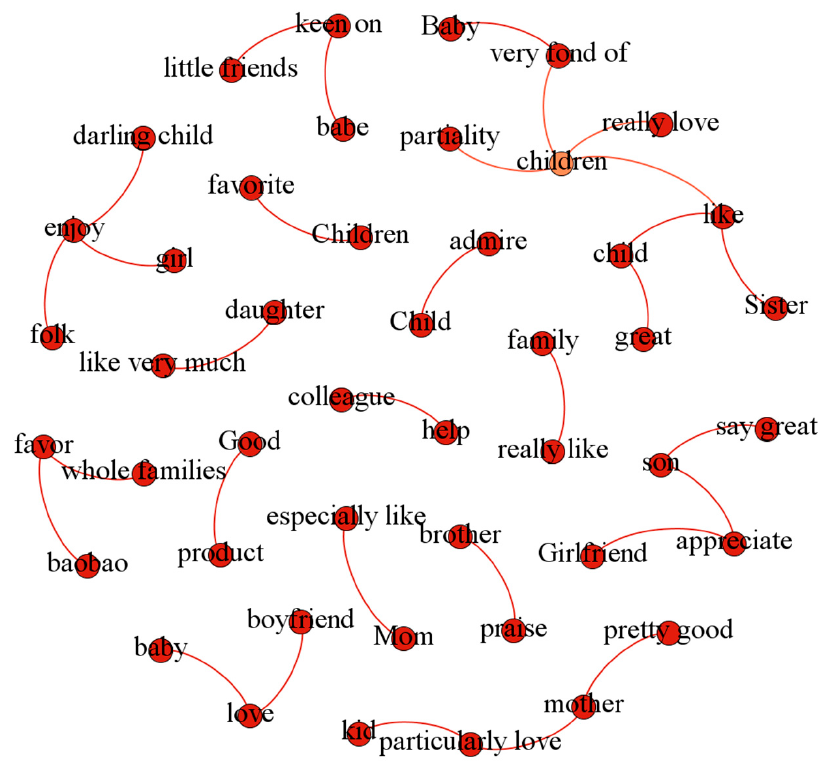
Figure 10. The association network under the positive emotion of the topic ‘Crowd’.